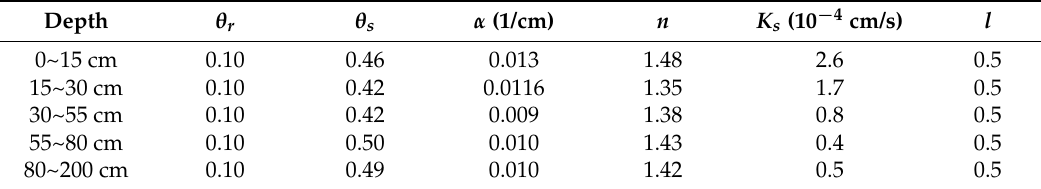
Table 4. Calibrated hydraulic parameters for the five soil zones in the model.